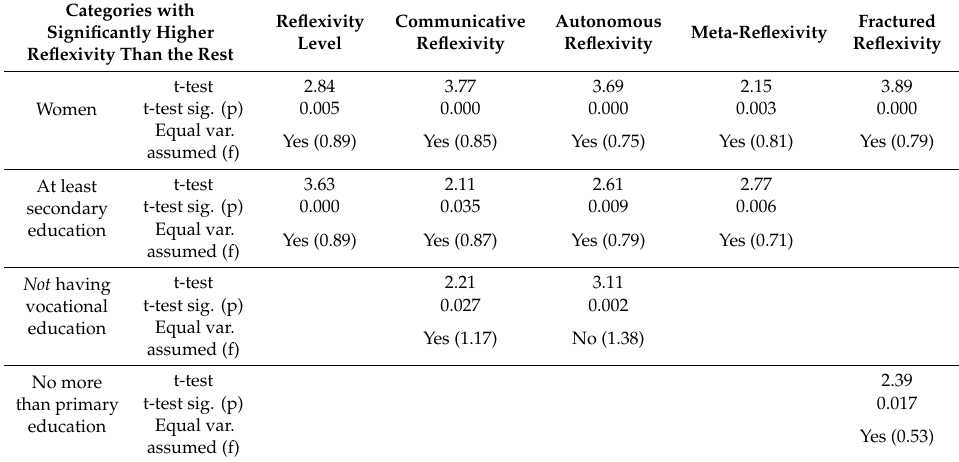
Table 4. T-test statistics comparing the categories with significantly higher reflexivity than the